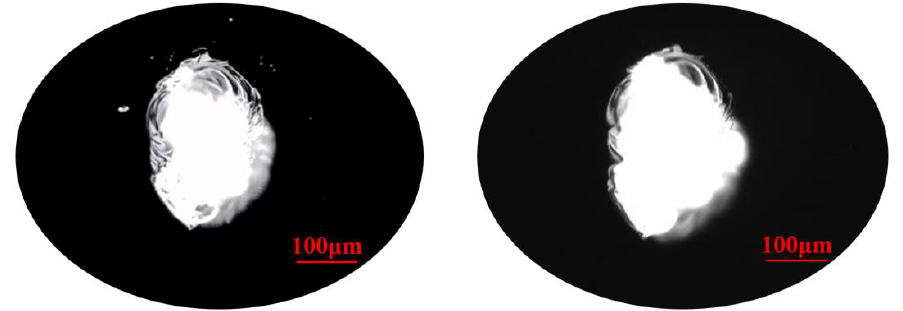
Figure 14. The morphology of large-scale defects before and after MRF process.